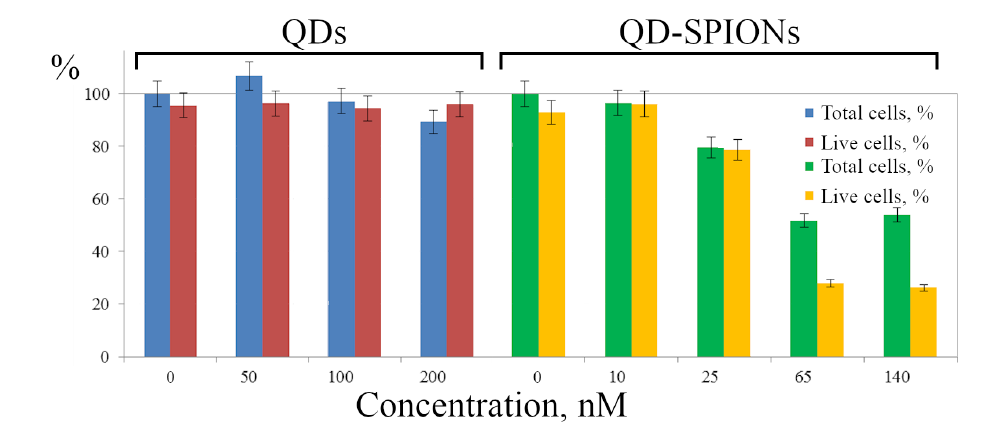
Figure 8. Analysis of HeLa cell viability during incubation with QDs and QD-SPIONs for 24 h. Data on the number of cells in the sample and the proportion of live cells (cell viability) are presented in %. The number of cells of control cells (no QDs or QD-SPIONs) was taken as 100%. The results represent a mean value ± standard error of the